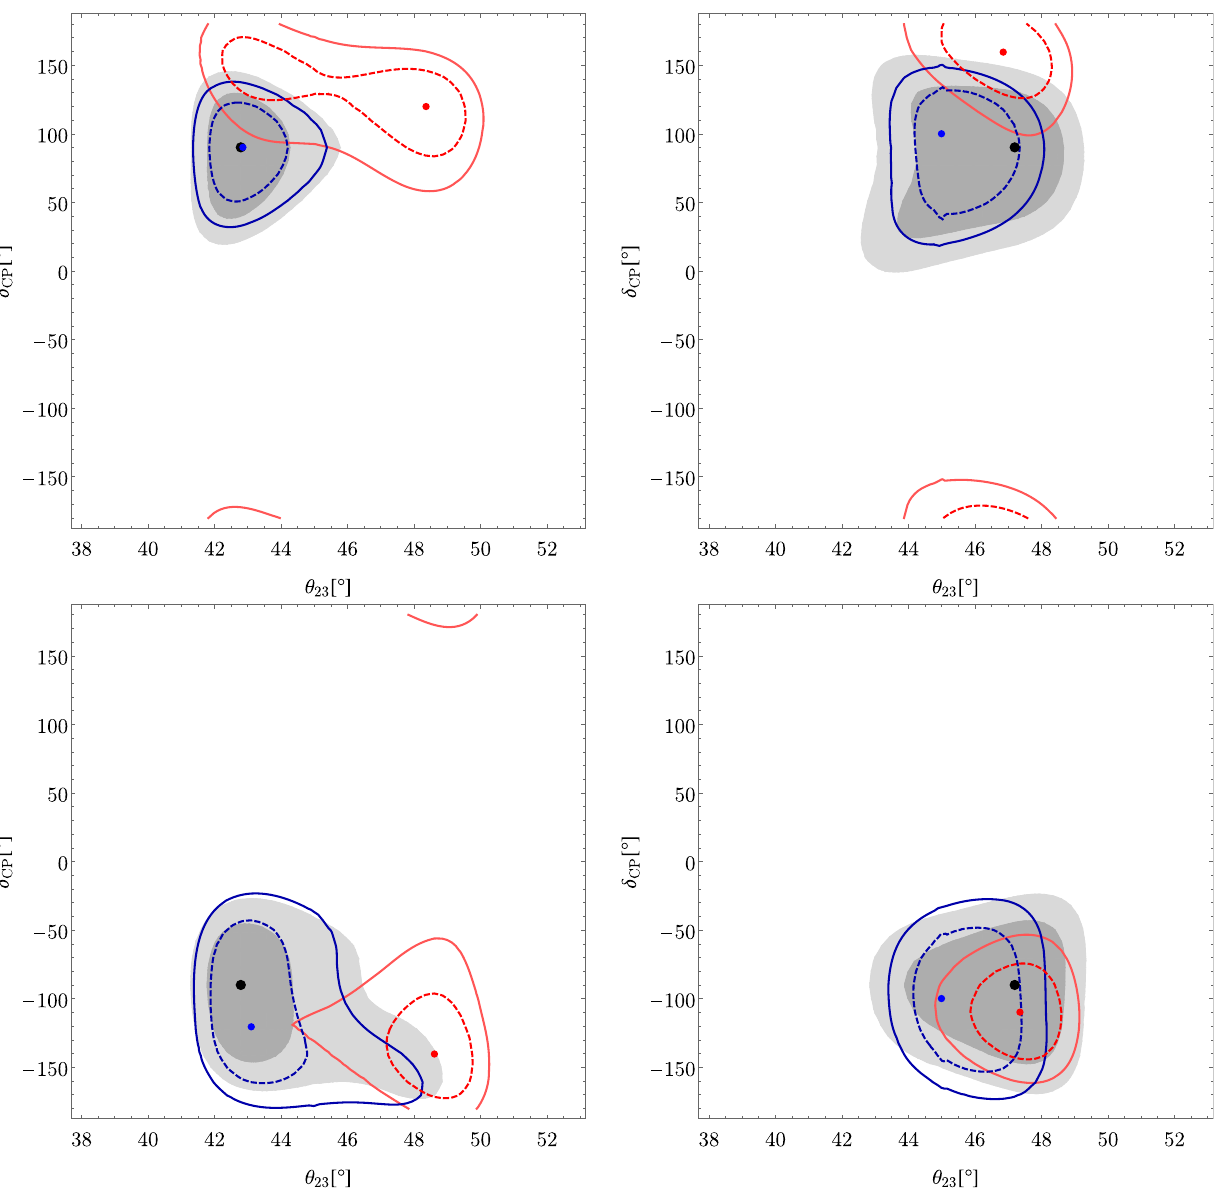
= 90 ◦ ( − 90 ◦ ). We take CP